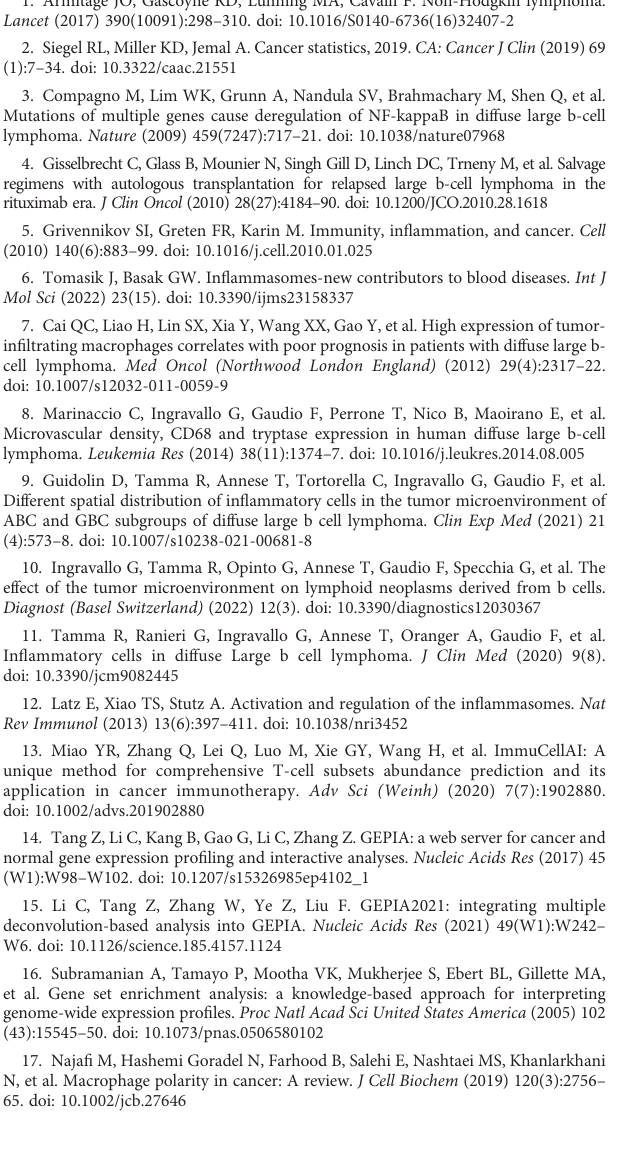
secondary lymphoid organ) tissue samples, with their fold change and P value,assessed usingthe GEPIA2deconvolution tool. E:Exponential function. P ≤ 0.05 was considered signi fi